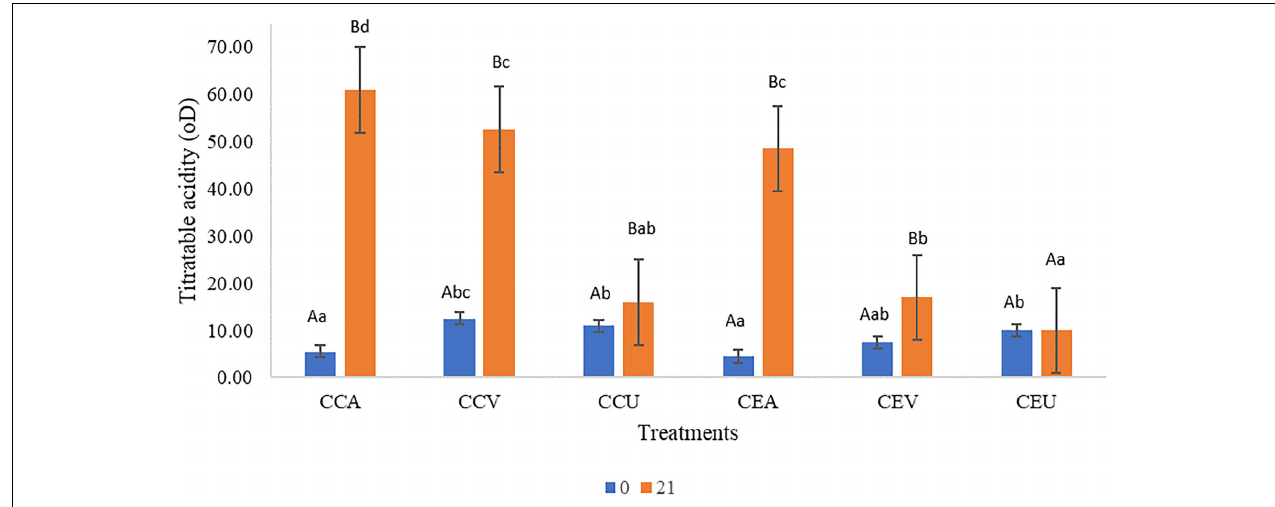
FIGURE 2 | Raw goat milk cheeses’ pH values during 21 storage days at 4 ◦ C. CCA = raw milk cheese without extract in aerobic packaging, CCV = raw milk cheese without extract in vacuum packaging, CCU = raw milk cheese without extract in vacuum packaging + UV-C, CEA = raw milk cheese with extract in aerobic packaging, CEV = raw milk cheese with extract in vacuum packaging; CEU = raw milk cheese with extract in vacuum packaging + UV-C. A–D Different lowercase superscripts indicate significant differences among storage times ( P < 0.05). a–d Different uppercase superscripts indicate significant differences among goat milk cheeses ( P <